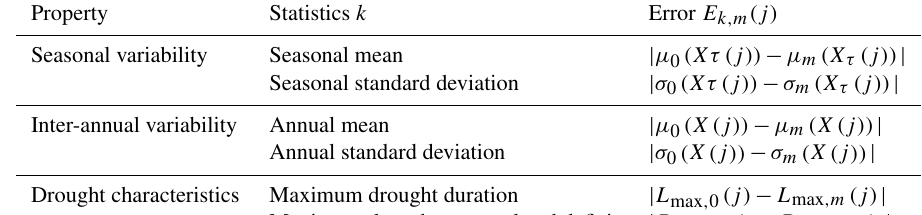
Table 5. Summary of the statistics involved in the ranking process. Statistics with subscript 0 refer to observed values.